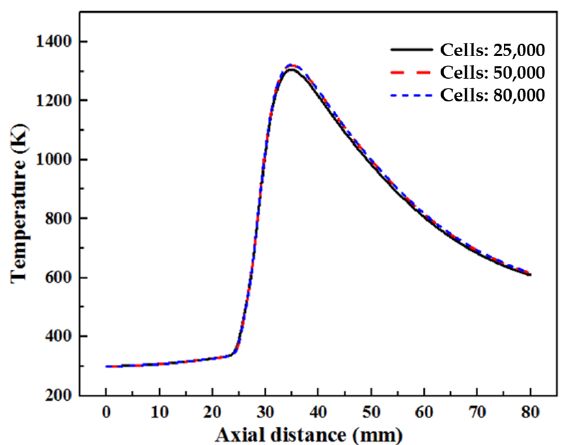
Figure 2. Temperature profile along the center line obtained by three grid systems at V f = 15 m/s for Model A.